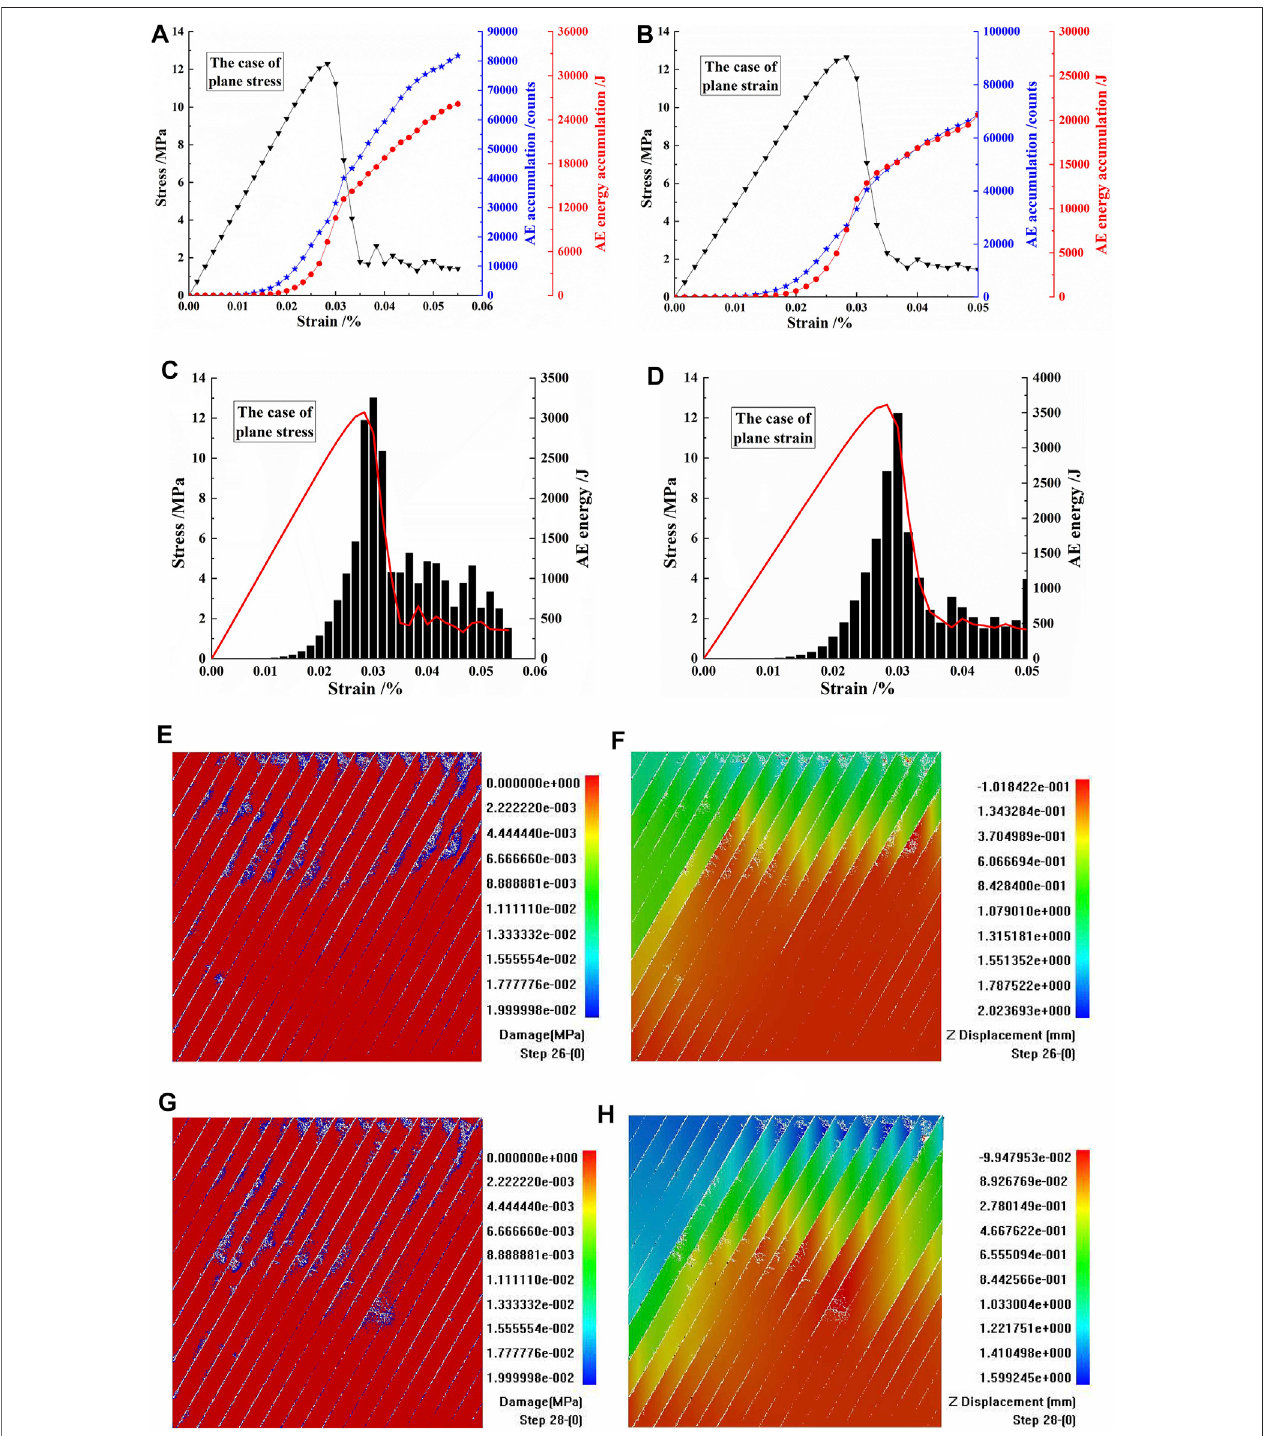
FIGURE 12 | (A,B) The stress – strain curves, acoustic emission (AE) accumulations, and AE energy accumulations of columnar jointed basalts (CJBs) in the direction parallel to the column axis, β (cid:2) 30 ° , for the case of plane stress and the case of plane strain, with a con fi ning pressure of 0 MPa. (C,D) The stress – strain curves andAEenergiesofCJBs, β (cid:2) 30 ° ,forthecaseofplanestressandthecaseofplanestrain. (E,F) Damageanddisplacementdiagrams, β (cid:2) 30 ° ,forthecaseofplanestress. (G,H) Damage and displacement diagrams, β (cid:2) 30 ° , for the case of plane strain.